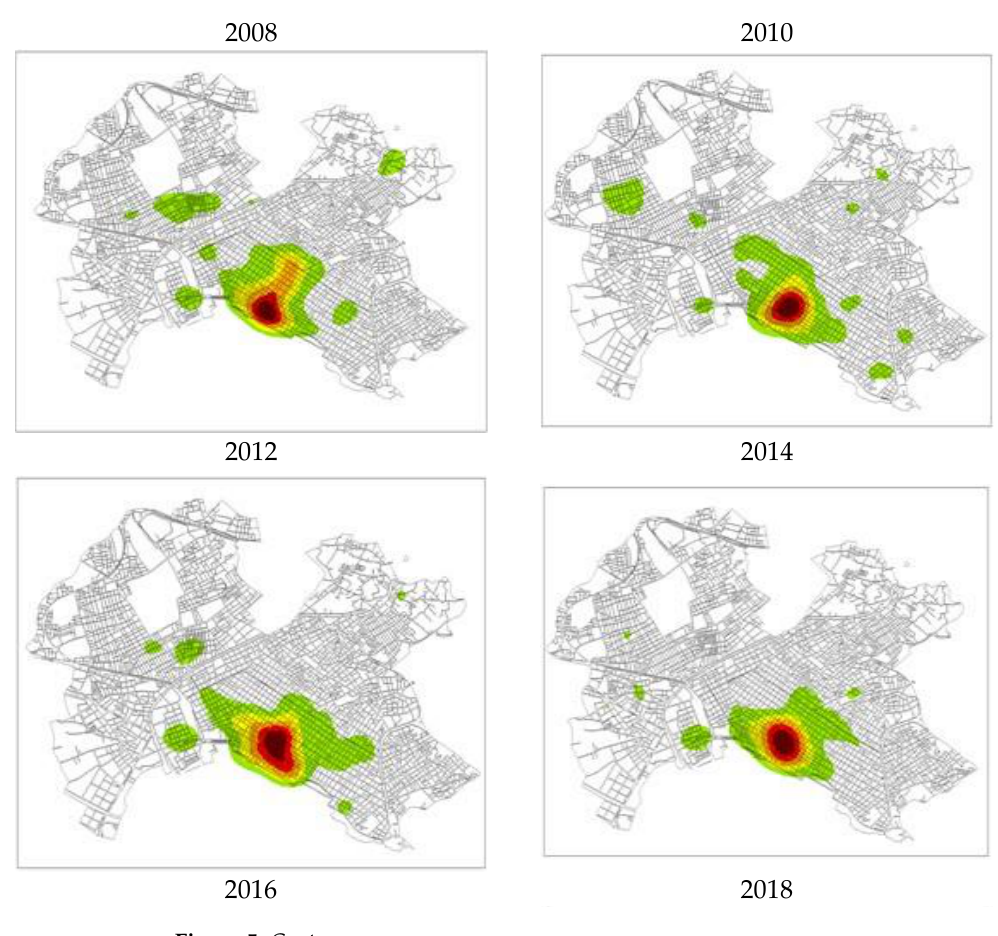
Figure 5. Kernel density for the years 2008 – 2018 for the companies that opened in the respective years, Source: Chamber of Magnesia, Own processing.